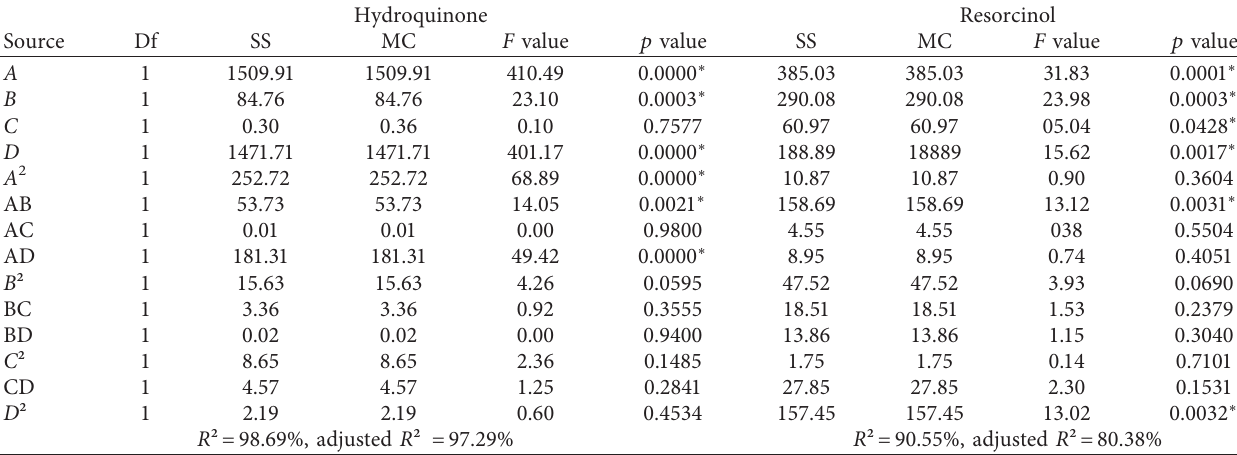
Table 6: Analysis of variance (ANOVA) of adsorbed quantity of hydroquinone and resorcinol by CAK-S. Hydroquinone Resorcinol